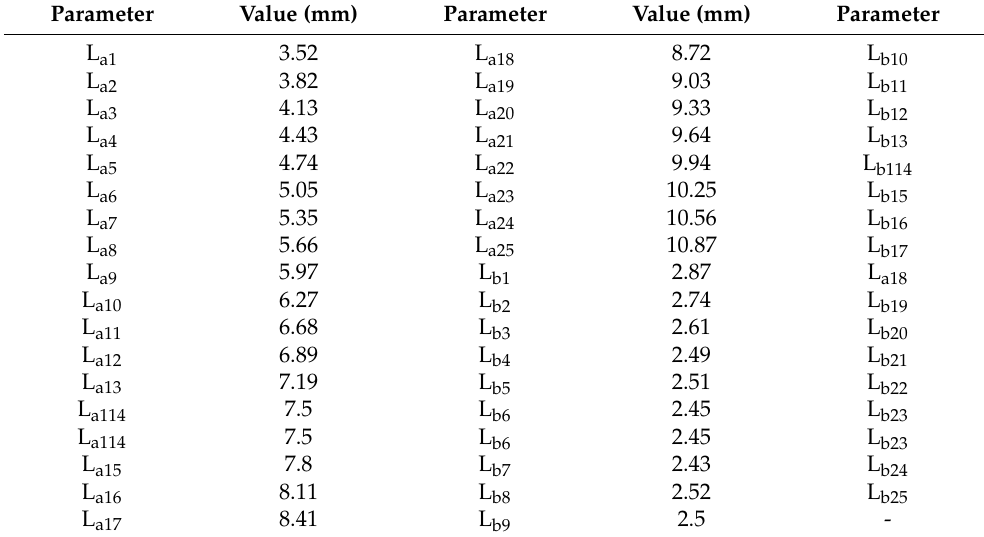
Table 3. List of optimized parameters for Tag 1.